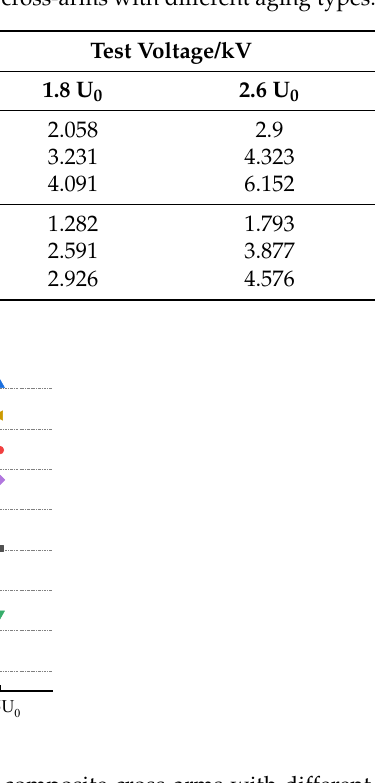
Table 5. The infrared absorption peaks of the main characteristic functional groups of the silicone rubber sheath.